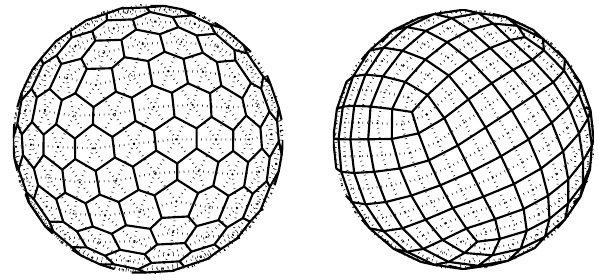
Figure 1. Left: a hexagonal–icosahedral grid with 162 cells and 642 degrees of freedom. Right: a cubed-sphere grid with 216 cells and 648 degrees of freedom. Continuous lines are primal grid edges, dotted lines are dual grid